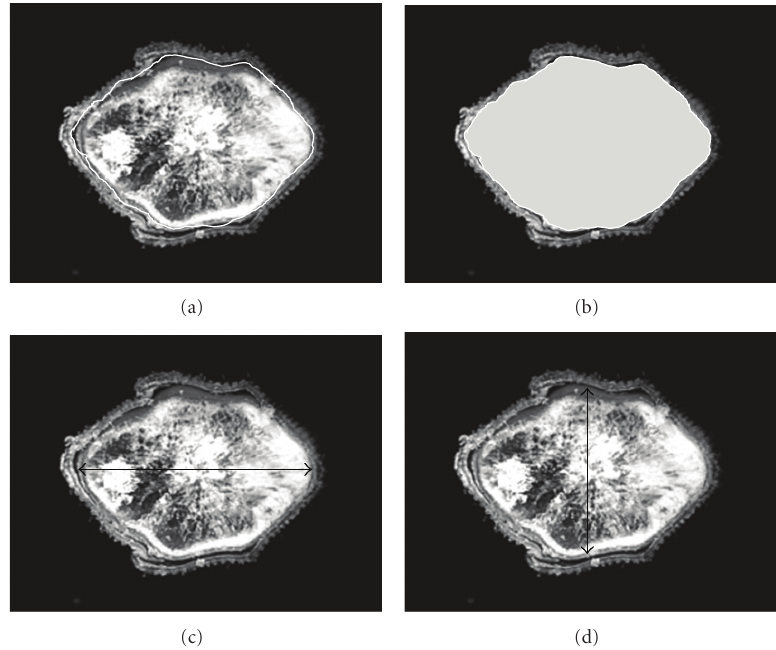
Figure 1: Micrographs of OM of the grain cross-section of rice Morelos A-98 (3X) showing evaluated morphometric descriptors: (a) peri- meter, (b) area, (c) maximum length, and (d) minimum length.